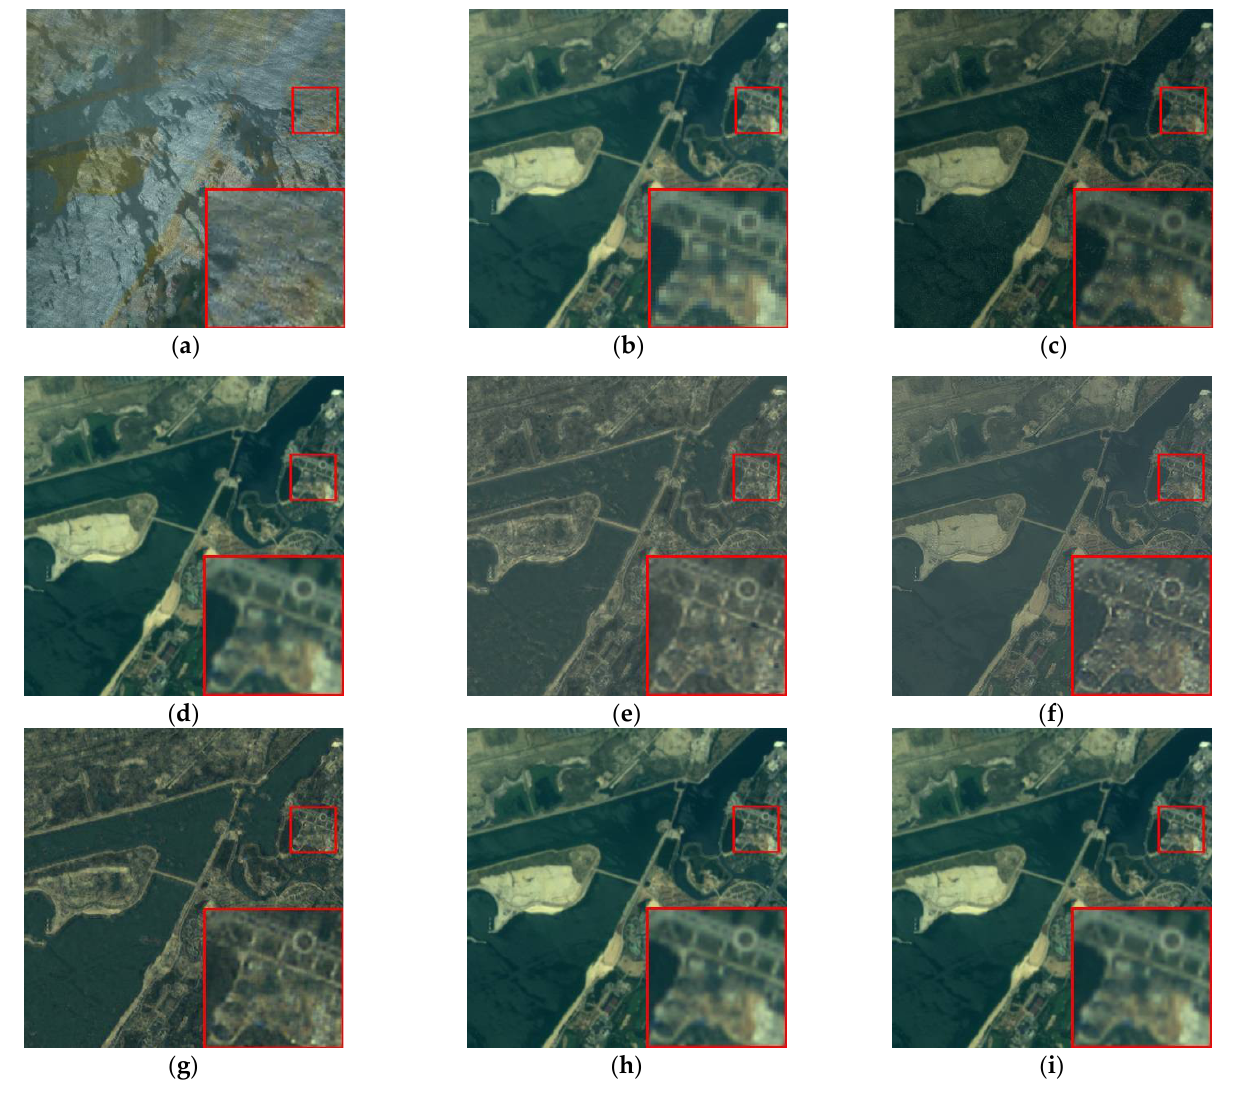
Figure 13. Fused images of GaoFen-1 where ( a ) IHS, ( b ) Wavelet, ( c ) HPF, ( d ) PRACS, ( e ) PNN, ( f ) Fusion-Net, ( g ) SSConv, ( h ) DS-MDNP, and (i) Bicubic.